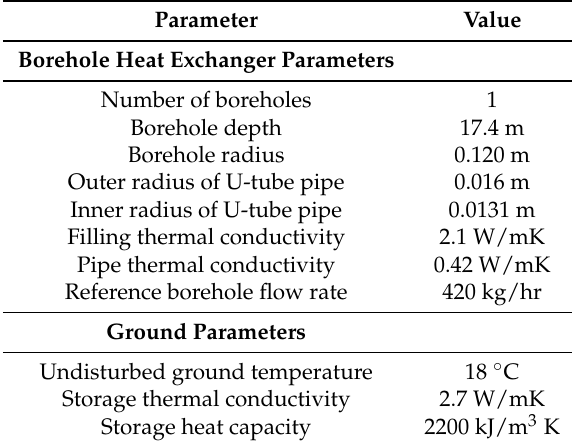
Table 4. Description parameters of the single U BHE Type.